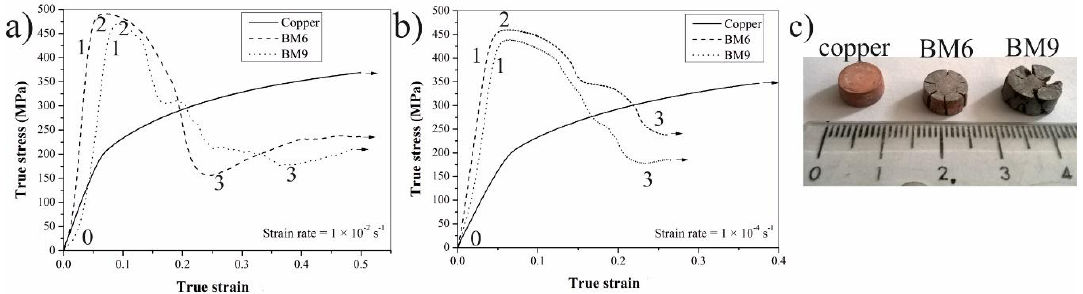
Figure 8. Compressive stress-strain curves of the composites: ( a ) strain rate of 10 −2 s −1 ; ( b ) strain rate of 10 −4 s −1 ; ( c ) macrographs of the compressed samples.